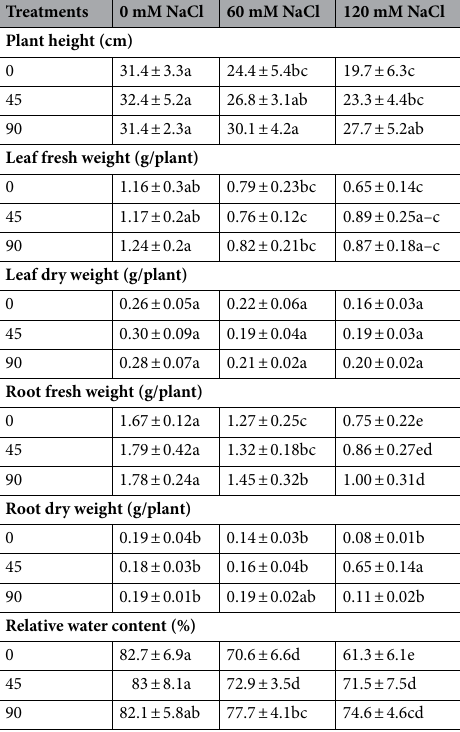
Table 2. The interactive effects of sodium chloride (NaCl) salinity and silver nanoparticle on some growth characteristics of Roselle. Within a column, means followed by the same letter are not significantly different (P <